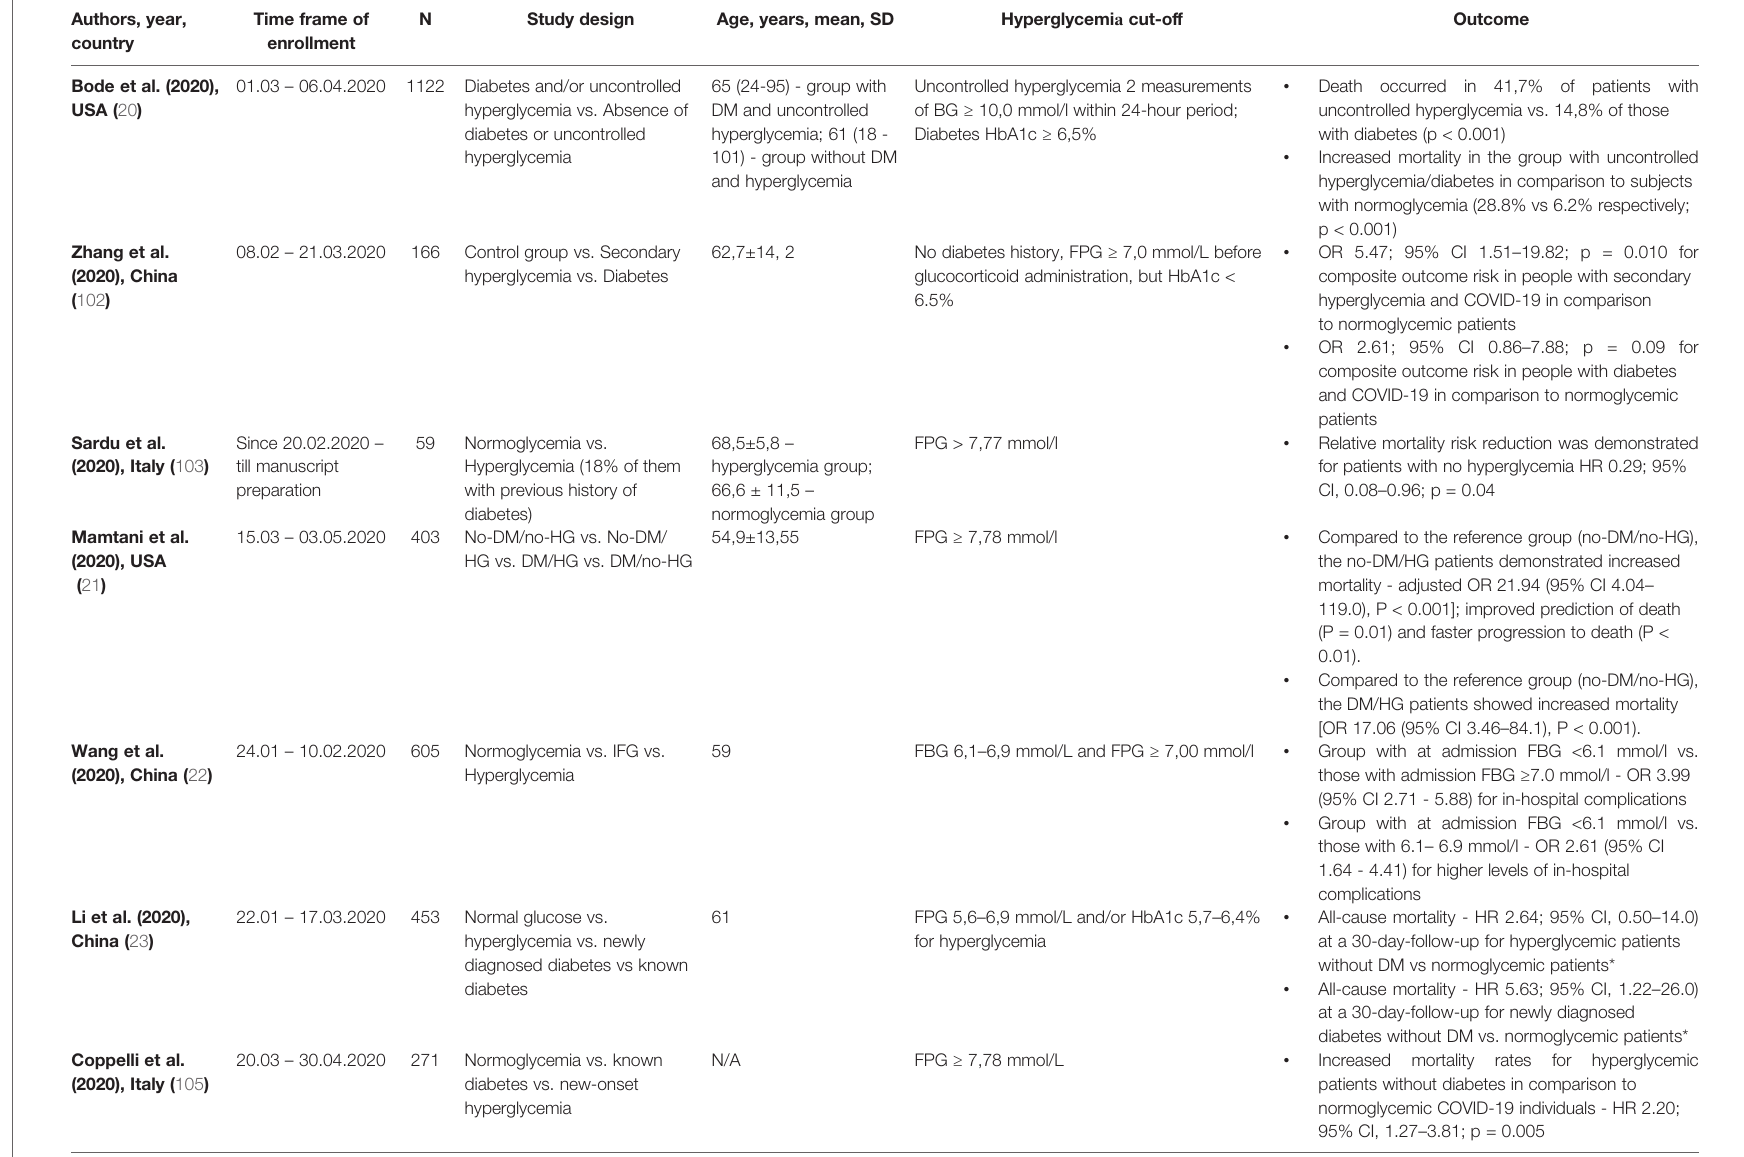
TABLE 1 | Summary of studies dedicated to new-onset hyperglycemia/new-onset